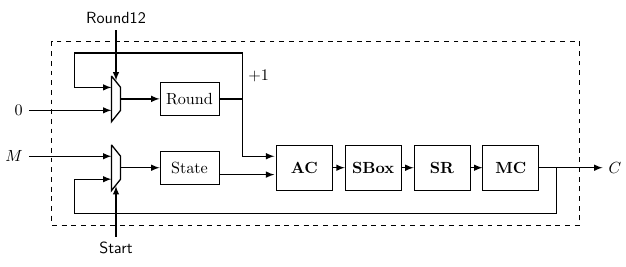
Figure 5: Hardware circuit diagram for Round Based Implementation of